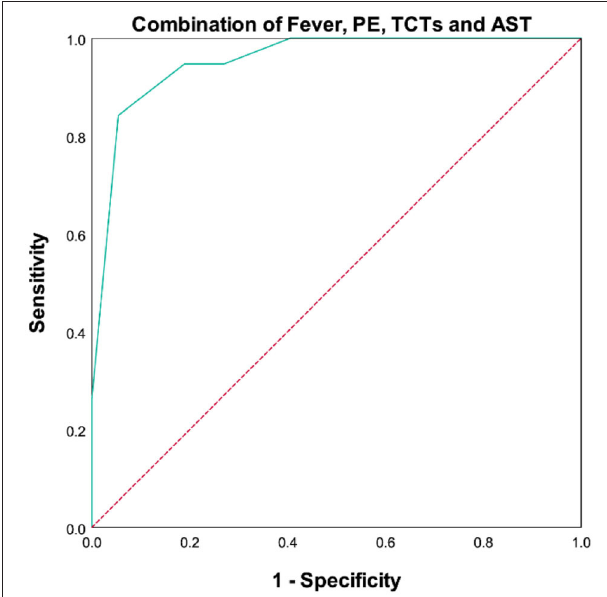
FIGURE 5 | ROC curves of combination of fever, PE, TCTs, and